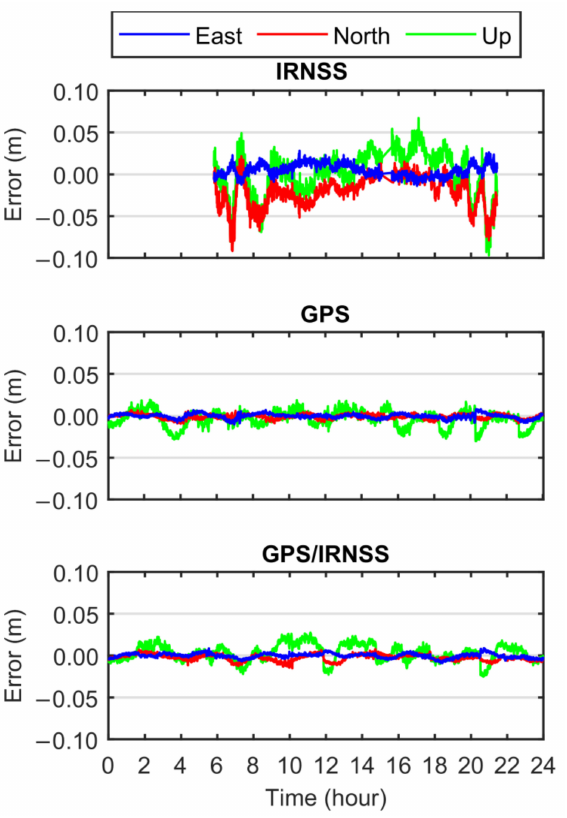
Figure 15. Epoch-wise position errors of the ambiguity-fixed solutions for IRNSS-only, GPS-only, and GPS/IRNSS short-baseline RTK on 7 July